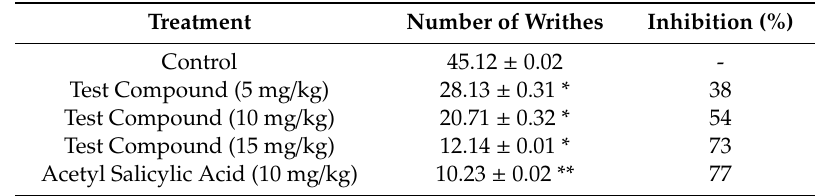
Table 1. E ff ect of quercetin-3-methoxy-4 (cid:48) -glucosyl-7-glucoside on acetic acid-induced writhing in mice.